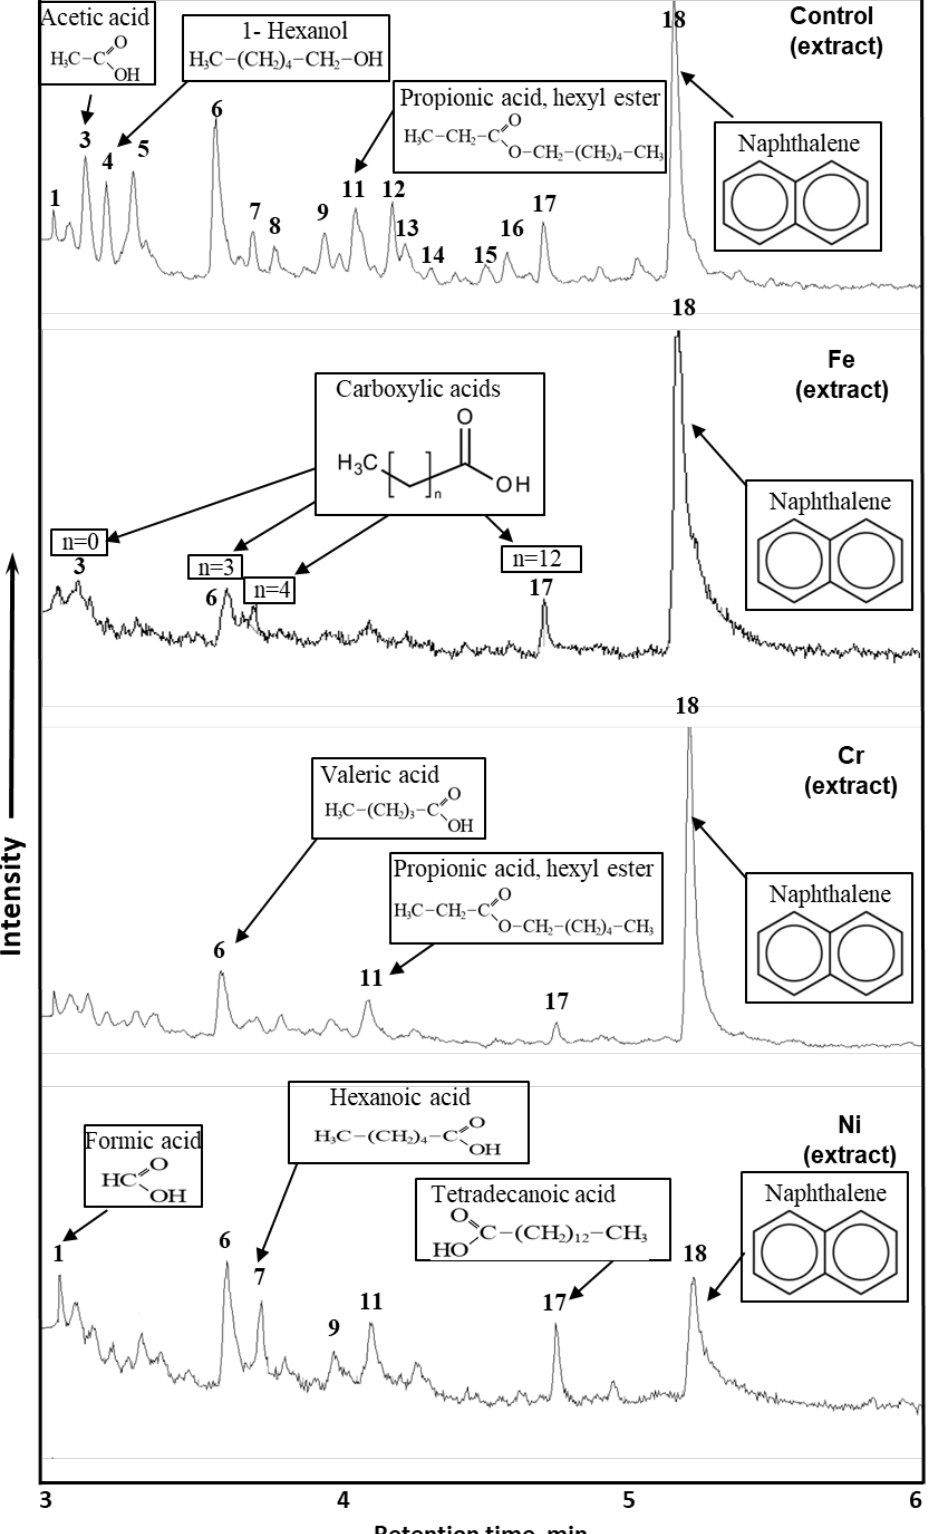
Figure 6. GC-MS spectra of silica extracts after liquid-phase oxidation of n-hexane in the presence and absence of catalysts.